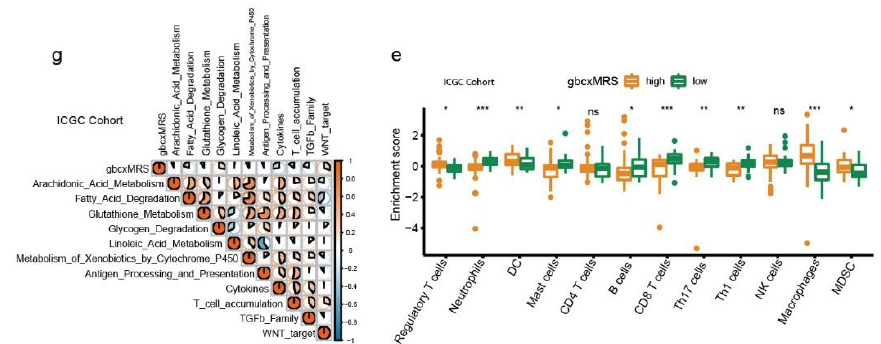
Figure 7. GbcxMRS predicted PDAC subtypes and influenced the tumor microenvironment (TME). ( a , b ) The landscape of the proportion of different PDAC subtypes in the high and low gbcxMRS